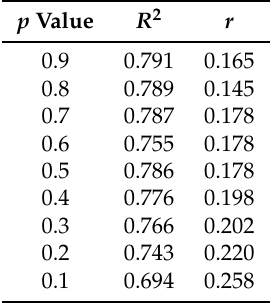
Table 3. Results under different p